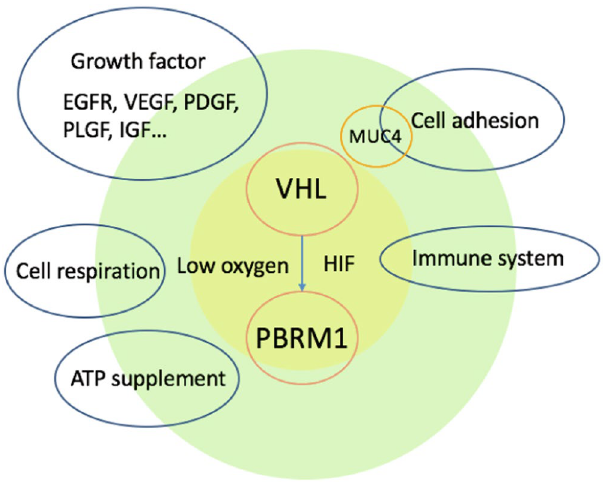
Figure 4. Schematic diagram of biology process during KIRC